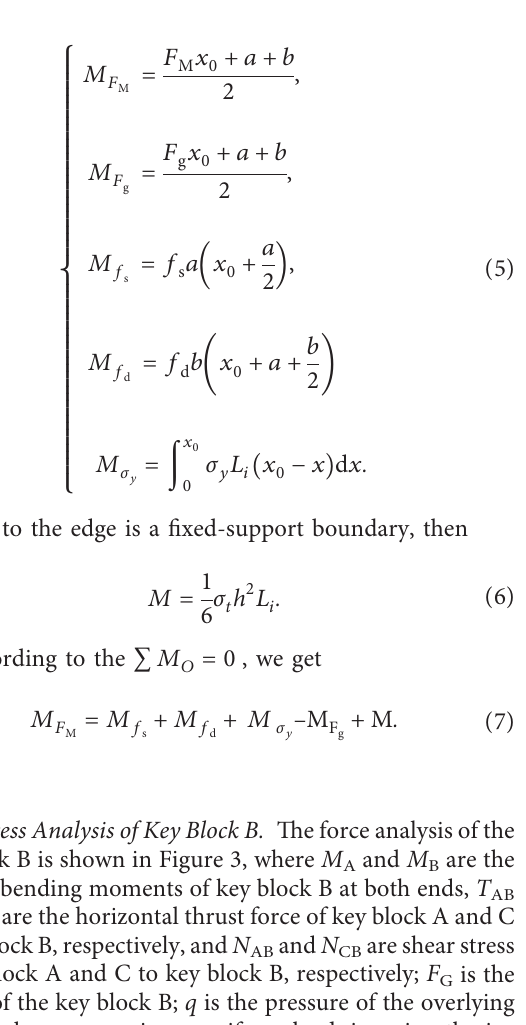
Figure 1: Basic roof failure mechanics model in gob-side entry retaining. (a) Basic roof failure form. (b) I-I section view.